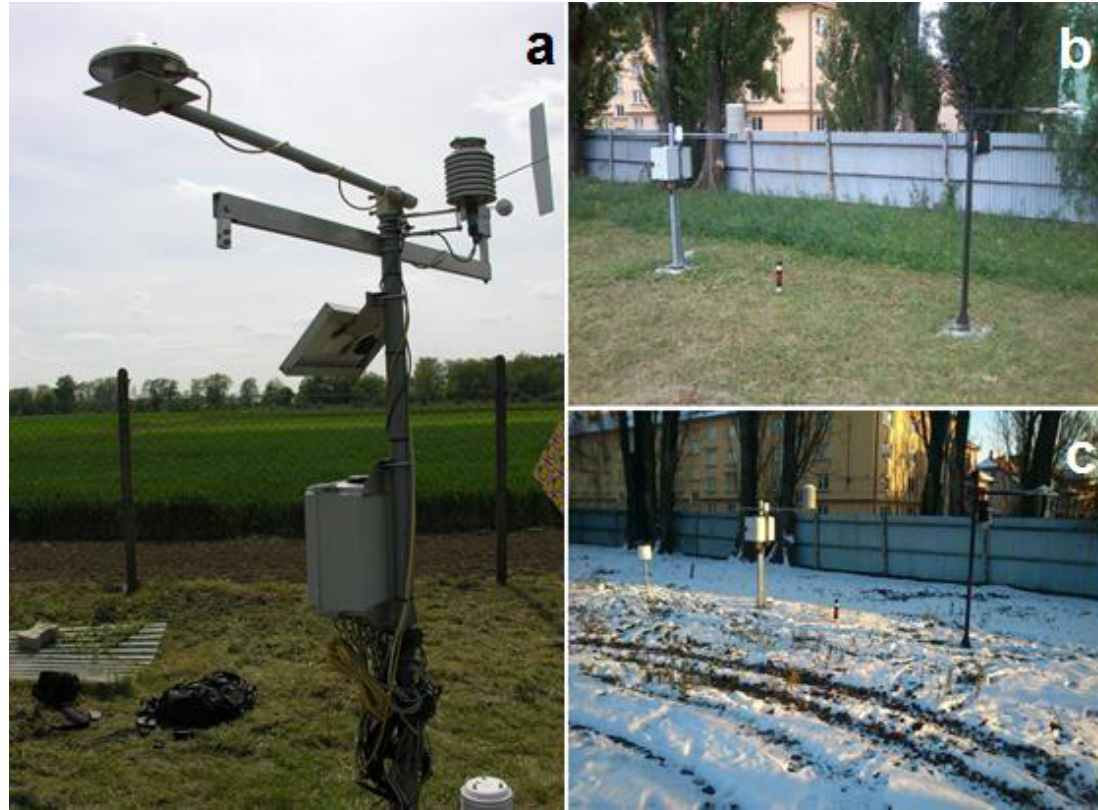
Figure 2. Diversity of the surroundings and occurrence of barriers on the example of stations Zab ( a ) and Met in the summer ( b ) and winter ( c ) period.